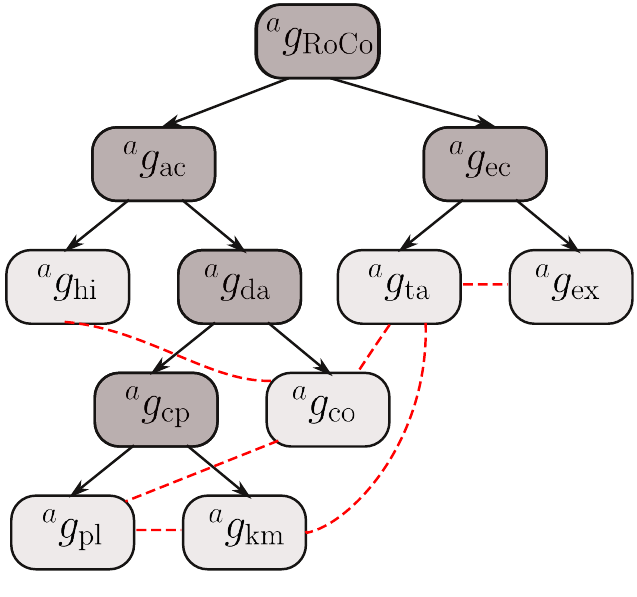
Figure 6. The decomposition after six steps of the